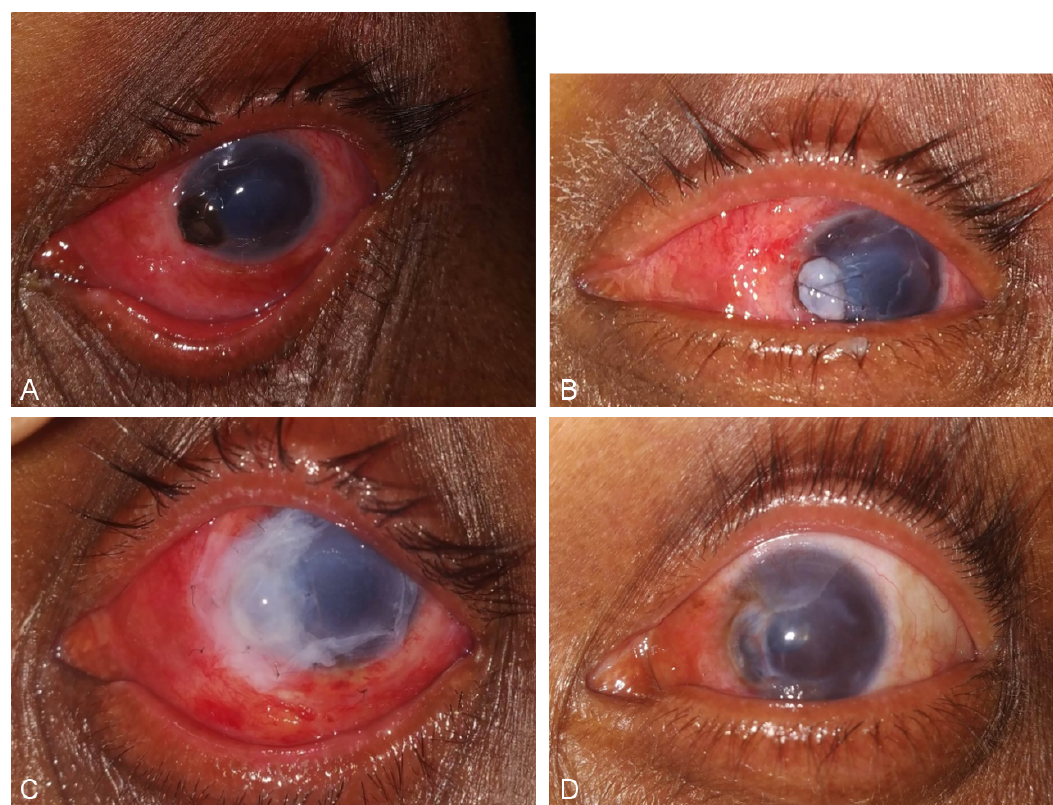
Figure 2: (A) Preoperative picture of LE showing peripheral corneal perforation with iris prolapse; (B) Tenon’s patch graft anchored to recipient bed with cross suture; (C) post-operative day 1; (D) post-operative 1